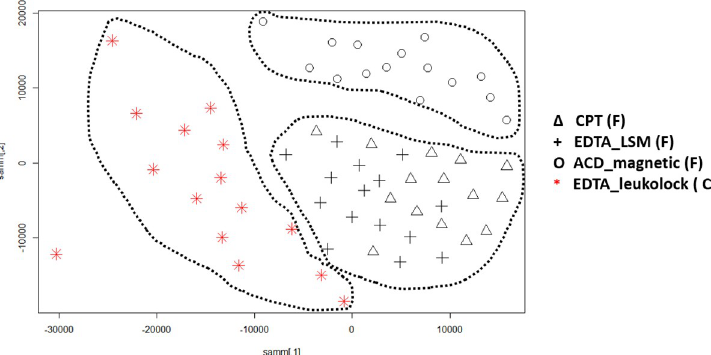
Fig 4. Sammon mapping using Manhattan distance of all probes for PBMCs sample separation methods where non- frozen LeukoLOCK ™ separated (red) and cryopreserved samples (black) are shown as two distinct groups. The legends are described Fig 3. The CPT tubes and LSM separated PBMCs are clustered together whereas magnetic separation and LeukoLOCK ™ separated PBMCs are clustered as distinct clusters with all clusters marked using a dotted line. The (F) and (C) denotes the frozen and cold conditions of the sample storage before RNA